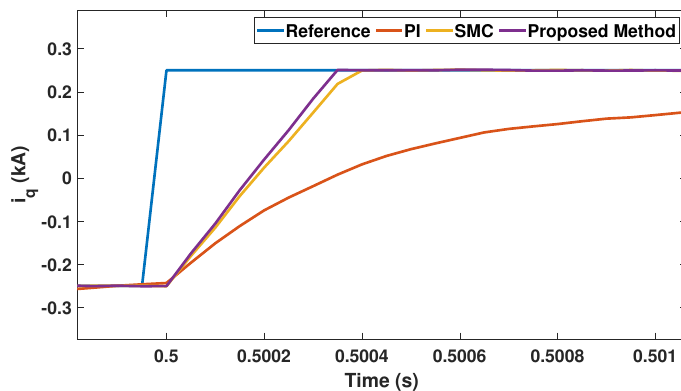
Figure 11. zoom-in of Figure